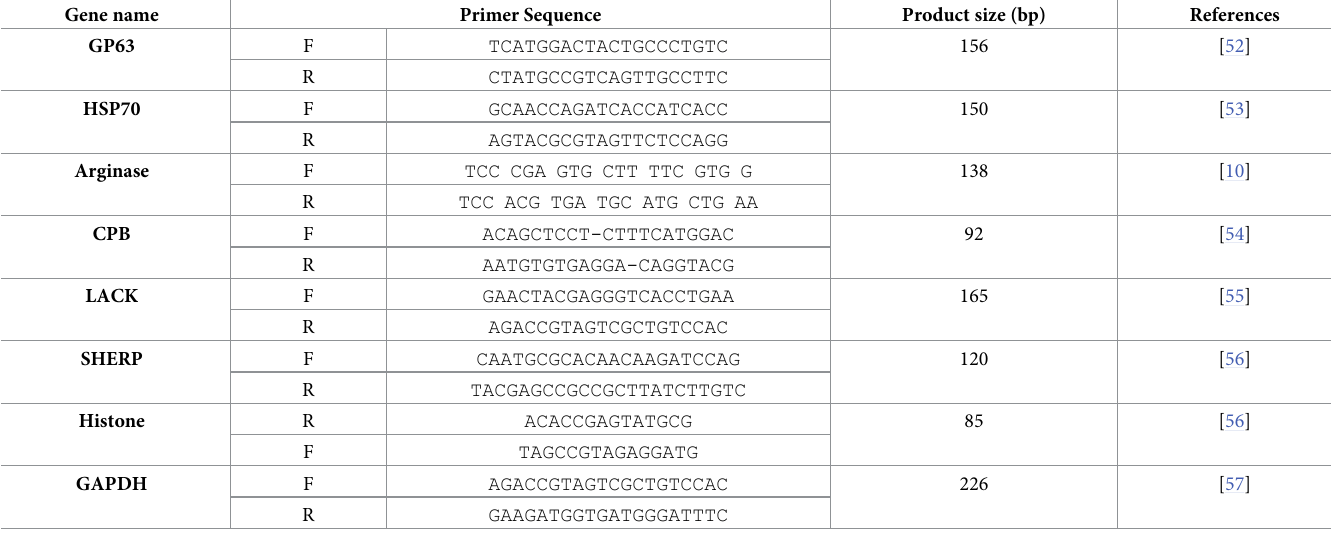
Table 1. The primers used for the amplification of seven virulence genes in L . major and GAPDH gene (RT- PCR). Gene